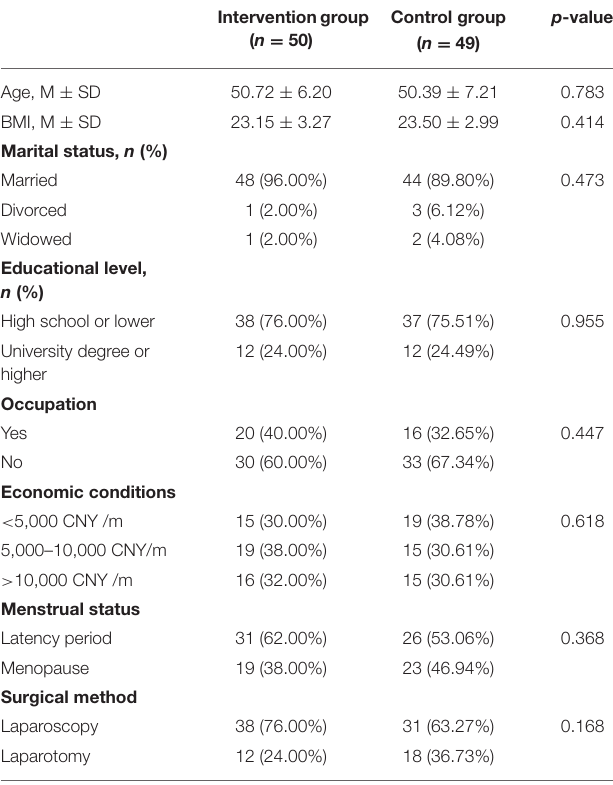
TABLE 1 | General characteristics of intervention group and control group.